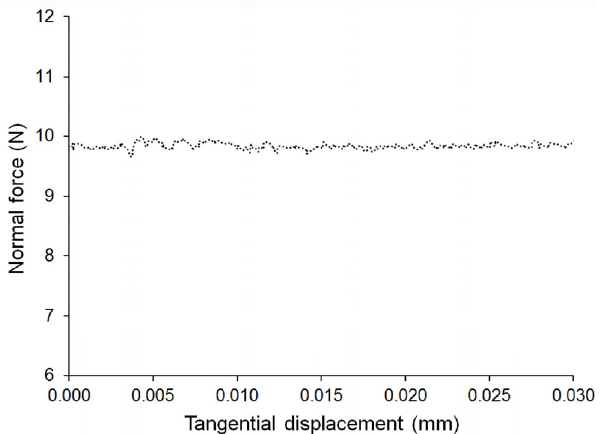
Fig. 9 Performance of the vertical micro-stepping motor in maintaining the normal force against tangential displacement during a shearing experiment on chrome steel balls .